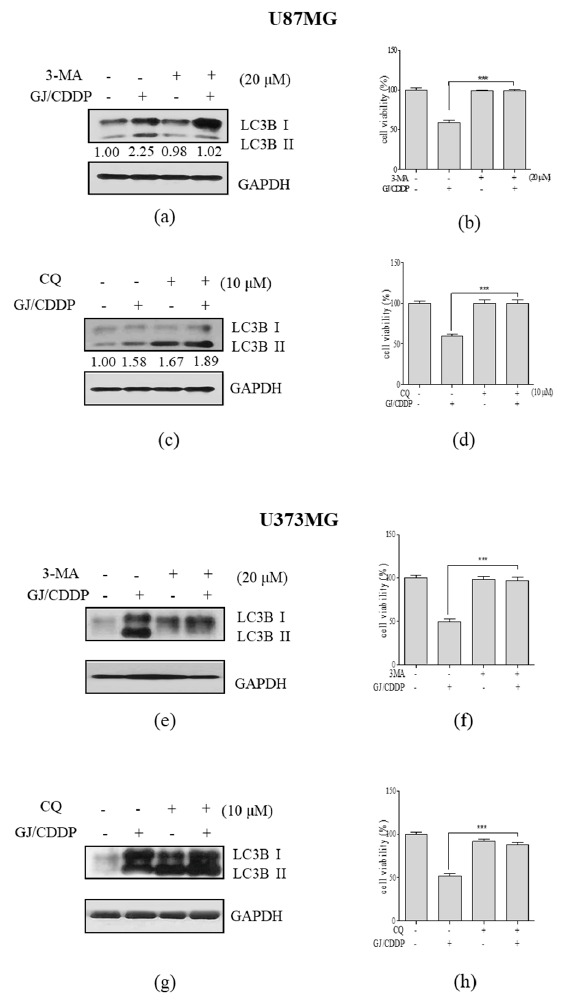
Figure 5. E ff ect of GJ / CDDP combination under autophagy-inhibited conditions in U87MG and Figure 5. Effect of GJ/CDDP combination under autophagy-inhibited conditions in U87MG and U373MG cells. ( a ) A Western blot assay on LC3B-I / II and ( b ) an MTT assay was performed in GJ / CDDP U373MG cells. ( a ) A Western blot assay on LC3B-I/II and ( b ) an MTT assay was performed in combination-treated U87MG cells after pre-treatment with 3-MA. ( c ) A Western blot assay on LC3B-I /